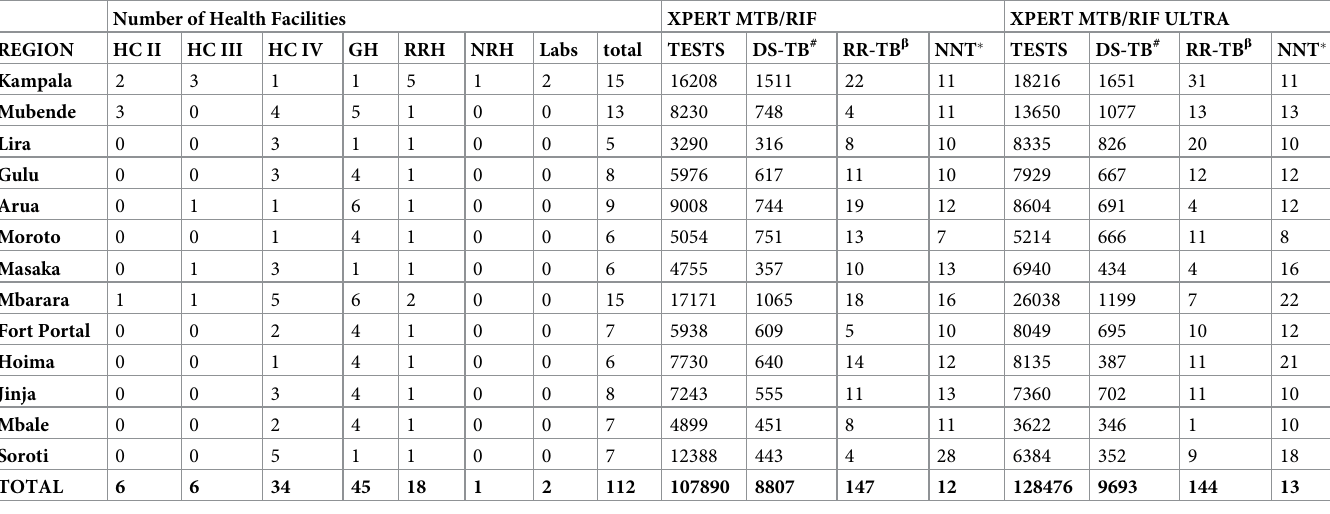
Table 1. Distribution of the sites across the regions, tests done, cases detected, and the number needed to test to detect one case. Number of Health Facilities XPERT MTB/RIF XPERT MTB/RIF ULTRA